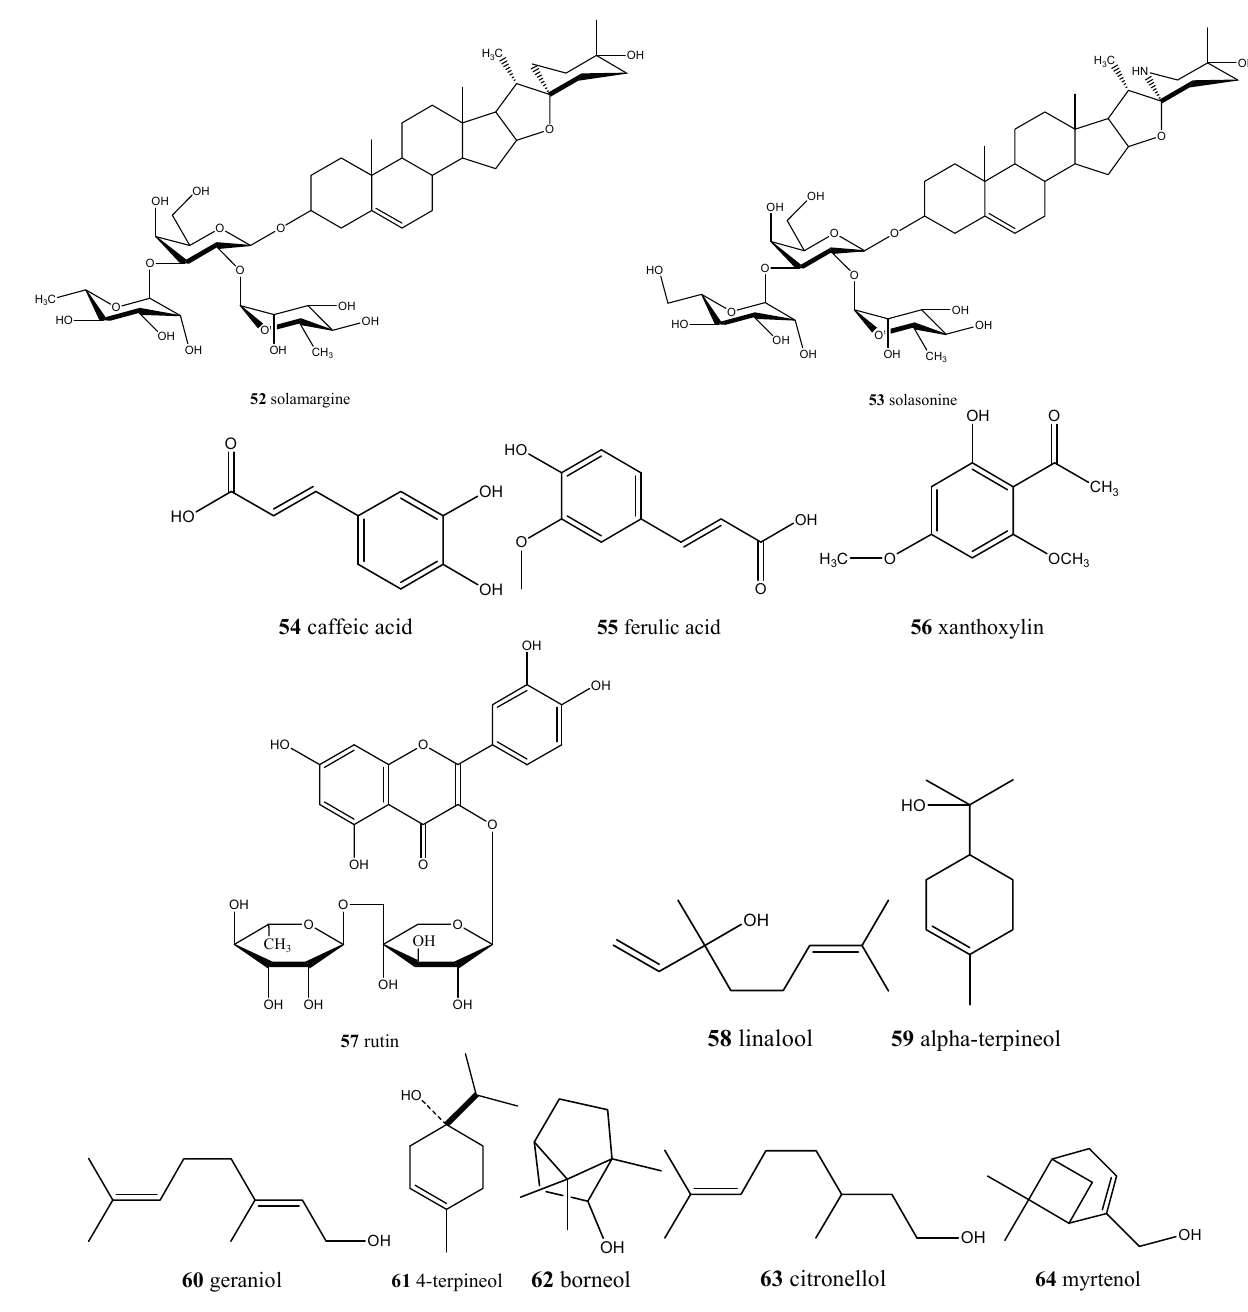
Figure 1. Molecular structures ( 1 to 64 ) of the compounds found in Cerrado